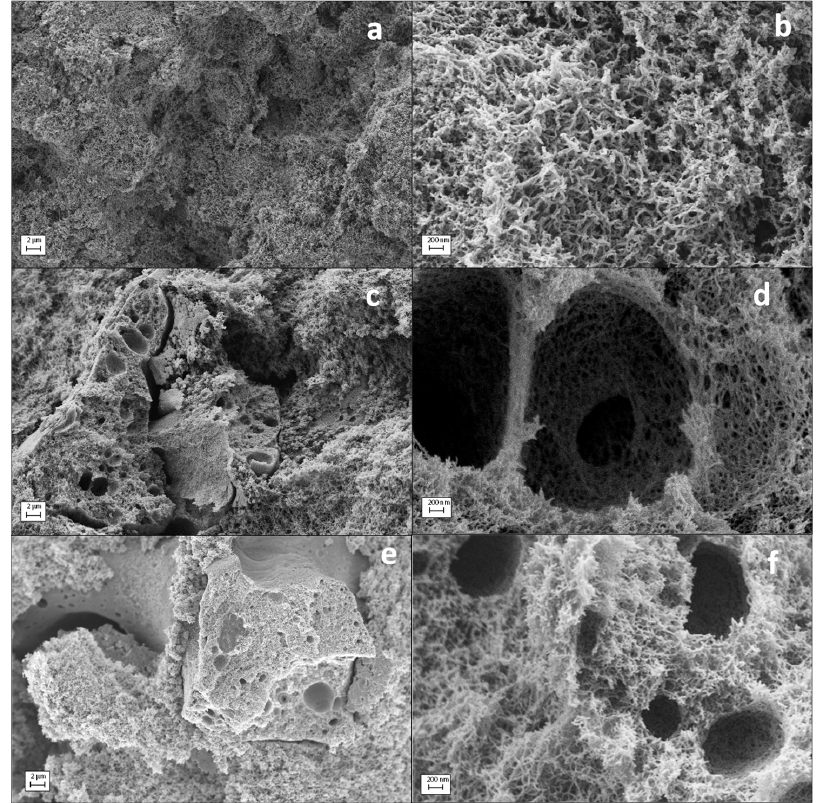
Figure 6. SEM images of cross-sections of sterile starch aerogels. The representative fibrous starch network is maintained after the sterilization treatment ( a , b ). The zein effect in ( c , d ) [Z1] S and ( e , f ) [Z2] S aerogel formulations was homologous to their unsterile aerogel counterparts. Higher magnifications unveiled areas of dual porosity identical to those obtained for untreated aerogels ( d , f